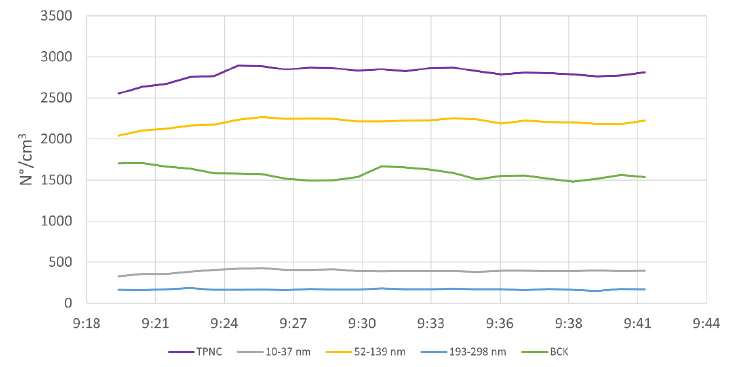
Figure 2. TPNC trends and the main particle size classes for O1–manual loading of the metal powder on the EOS 290 M.